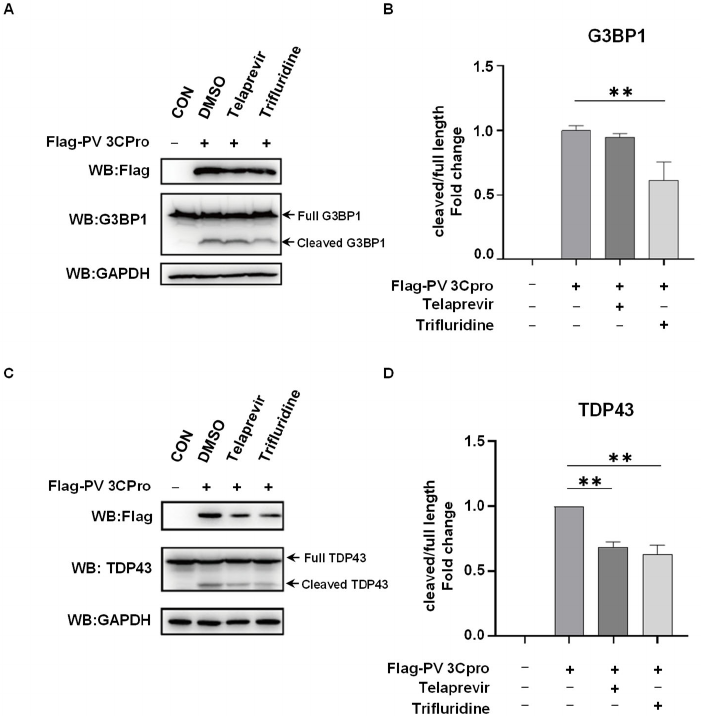
Figure 5. Telaprevir and Trifluridine suppress PV 3Cpro-mediated cleavage of host proteins. ( A ) 293T cells were transfected with Flag-PV 3Cpro or vectors, and were untreated or treated with 10 µM Telaprevir or Trifluridine 5 h after transfection, followed by Western blot with anti-Flag, anti-G3BP1, and anti-GAPDH antibodies. ( B ) Statistical analysis of the ratio of cleaved G3BP1 to full- length G3BP1 shown in panel ( A ). Data are shown as the mean ± SD ( n = 3). Statistics: Student’s t - test (**, p < 0.01). ( C ) 293T cells were transfected with Flag-PV 3Cpro or vectors, and were untreated or treated with 10 µM Telaprevir or Tri fl uridine 5 h after transfection, followed by Western blot with anti-Flag, anti-TDP43, and anti-GAPDH antibodies. ( D ) Statistical analysis of the ratio of cleaved TDP43 to full-length TDP43 shown in panel ( C ). Data are shown as the mean ± SD ( n = 3). Statistics: Student’s t -test (**, p < 0.01).